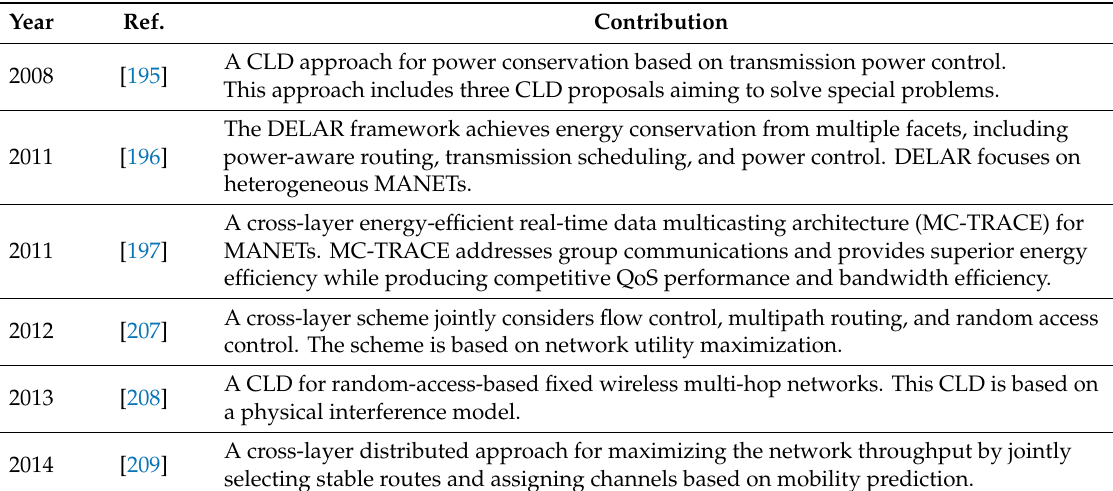
Table 3. Important contributions of cross-layer designs in